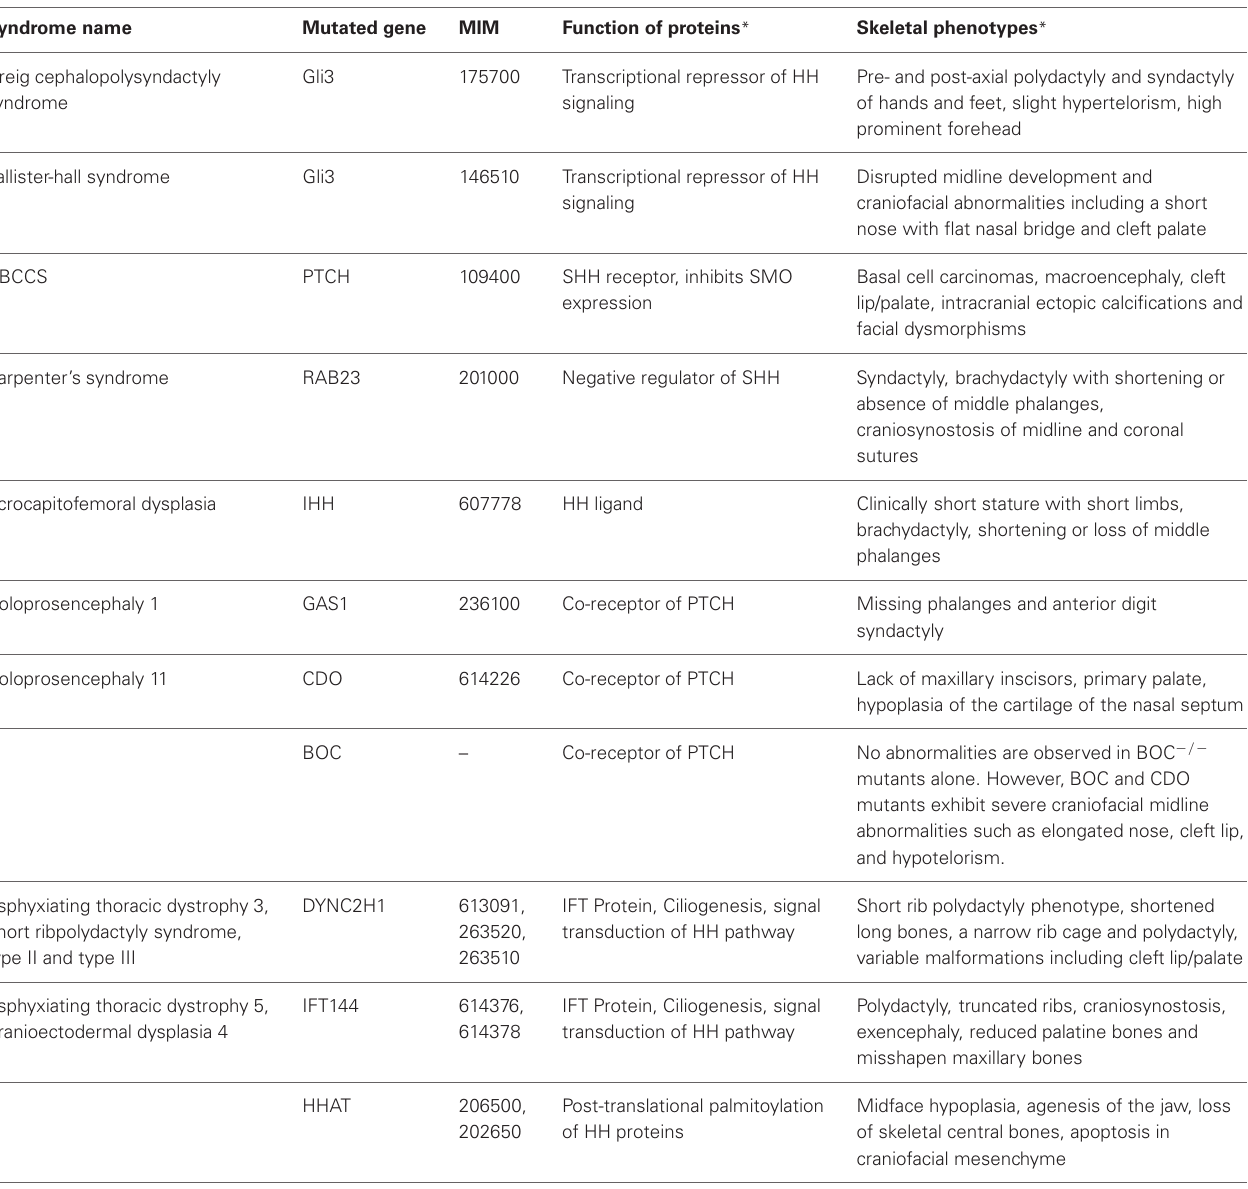
Table 1 | Genetic disorders in the hedgehog signaling